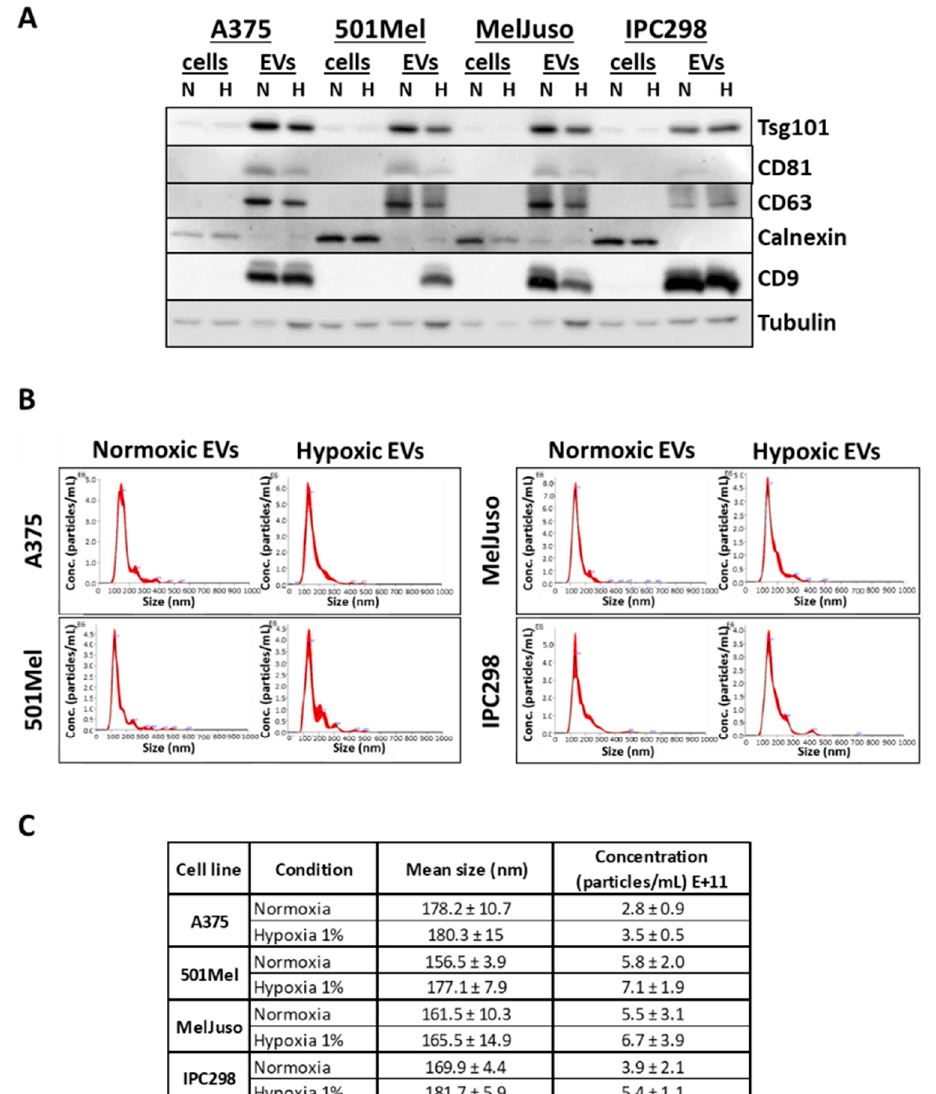
Figure 2. Characterisation of normoxic (N) and hypoxic (H) melanoma small extracellular vesicles (EVs) and whole cell lysates (cells). ( A ) Western blot of A375, 501Mel, MelJuso and IPC298 cells and EVs under normoxia or hypoxia, probed with antibodies against the EV markers Tsg101, CD81, CD63, CD9 and the endoplasmic reticulum marker Calnexin, as well as Tubulin. ( B ) Nanosight measurements of EVs from A375, MelJuso, 501Mel, IPC298 cells. ( C ) Size and concentration of EVs secreted under normoxia or hypoxia for the four melanoma cell lines as measured by Nanosight. Three biological replicates were used for each